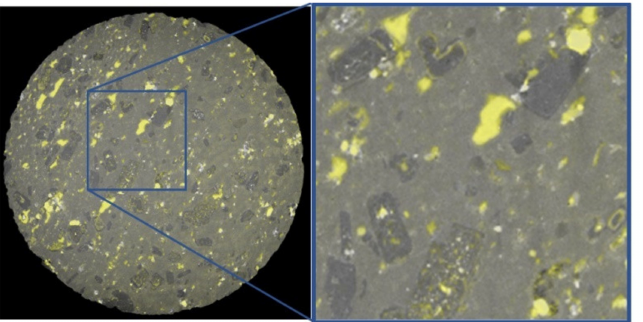
Figure 5. An opaque overlay of a Fe µ XRF map (yellow) over the matching µ CT orthoslice showing minor inaccuracies in the registration between the two